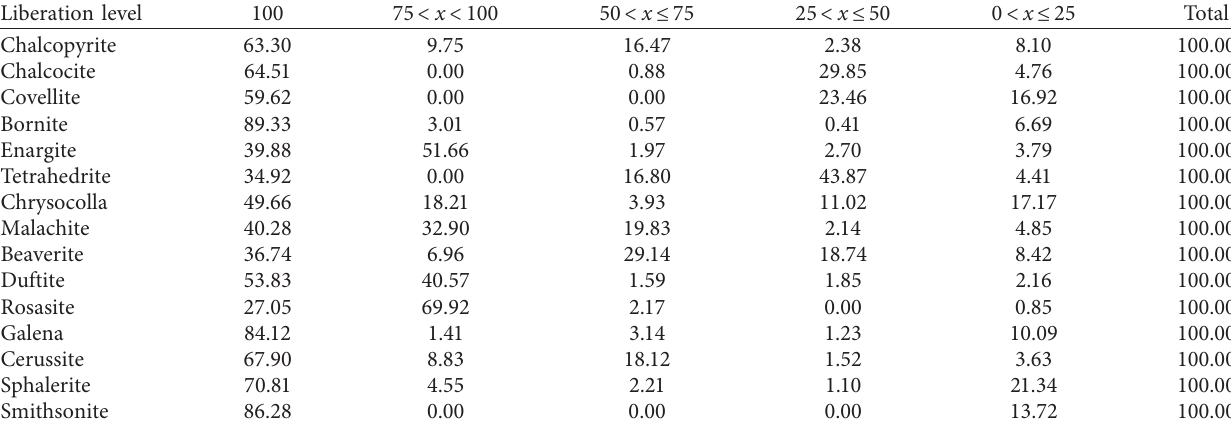
Table 7: Distribution of main minerals of copper, lead, and zinc (%).